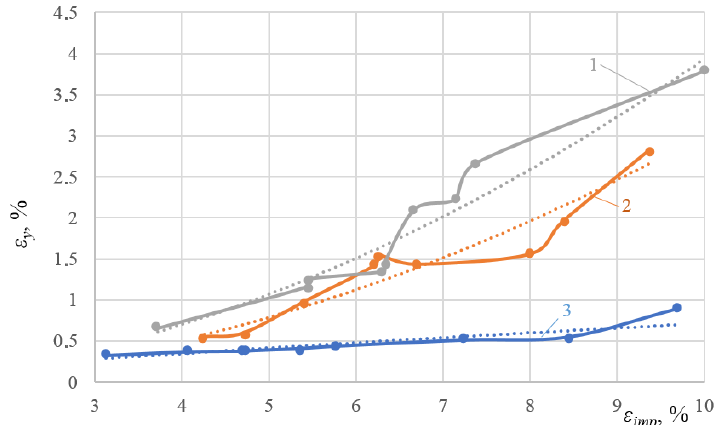
Figure 13. Experimental dependences between DNPs (with the relevant ε imp parameter) and the length of yield sites ε y in alloys: 1 — alloy 2024-T361; 2 — alloy D16ChATW; 3 — alloy T. The corresponding data approximations are shown in Figure 13 below: